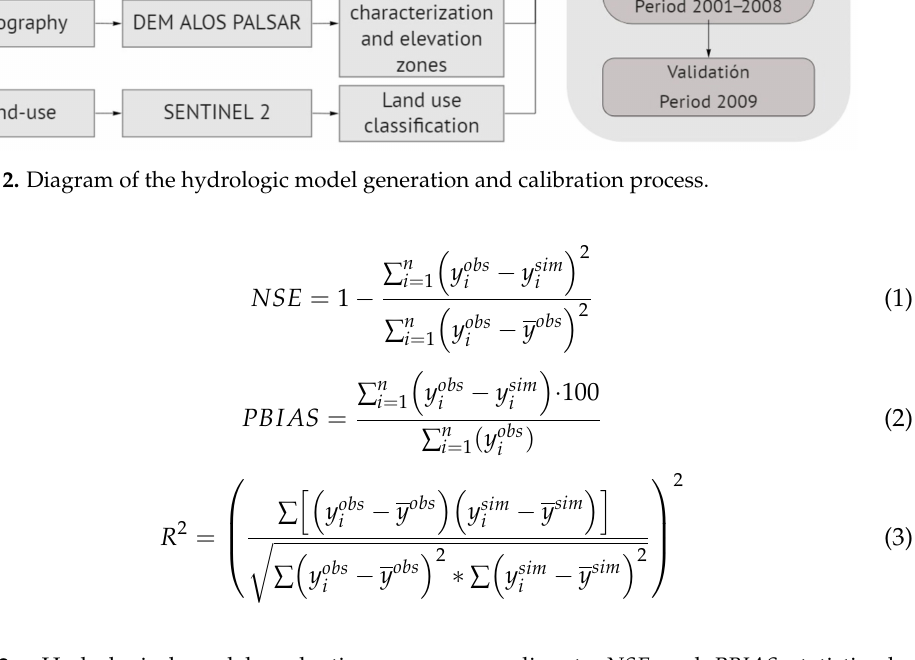
Hydrological model evaluation ranges according to NSE and PBIAS statistics by Moriasi et al.